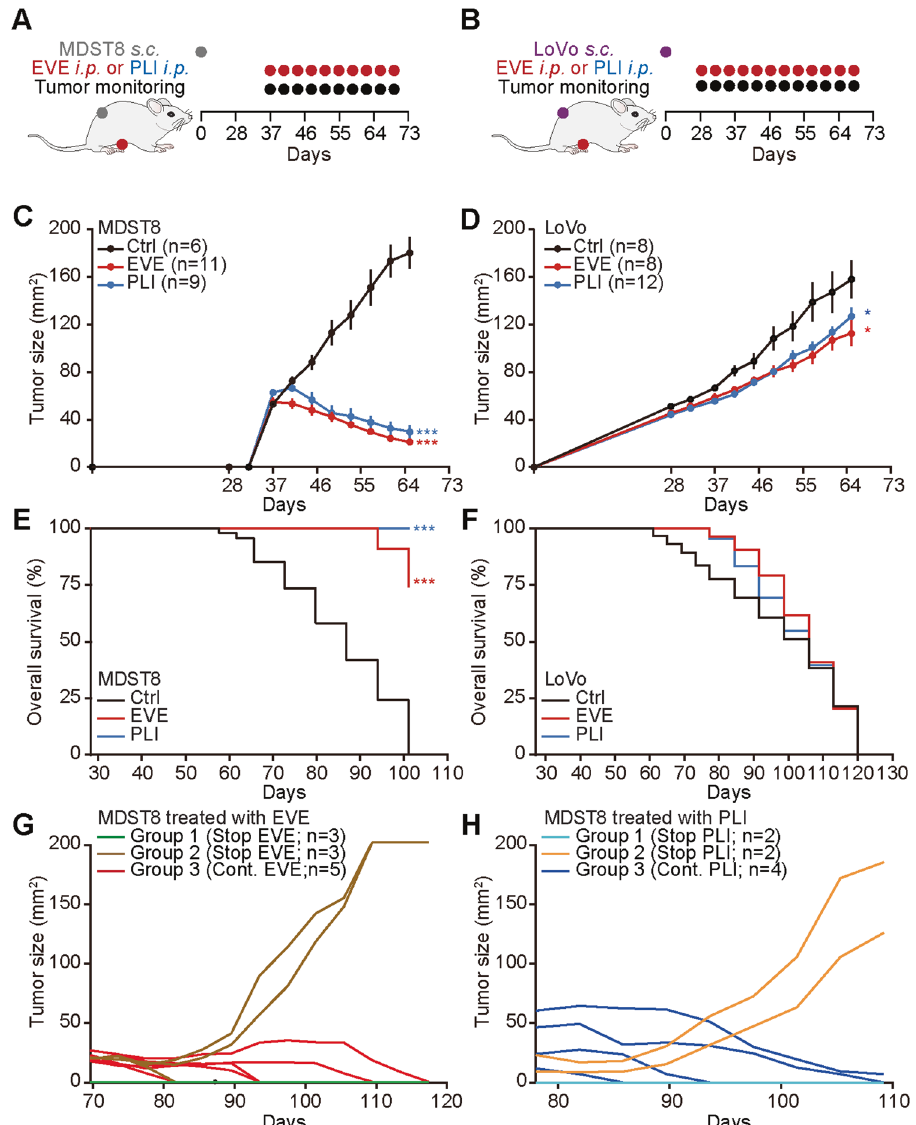
Fig. 6 Everolimus and plicamycin exhibit anticancer effects against CMS4 tumors. A , B Schematic overview of the treatment schedule of LoVo or MDST8 tumors with everolimus (EVE) and plicamycin (PLI) in vivo. C – H Five million human colon cancer MDST8 or LoVo cells were injected subcutaneously (s.c.) into the fl ank of athymic immunode fi cient nu/nu mice. When tumors became palpable, mice received a systemic intraperitoneal injection of EVE or PLI. n ≥ 6 mice per group. Results (means ± SD tumor growth curves) are plotted (* P < 0.05, *** P < 0.001). Overall survival is depicted, and P values (*** P < 0.001) were calculated with a Log ‐ rank test ( E , F ). After EVE/PLI treatment, mice bearing MDST8 tumors were divided into three different groups, and tumor growth was monitored upon continuation or discontinuation of the treatment as indicated ( G , H